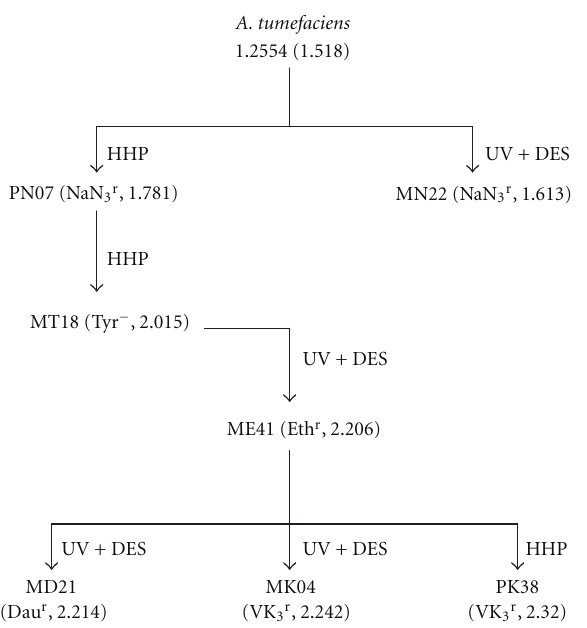
Figure 2: Genealogy of mutant strains derived from AT 1.2554. Mutation markers: NaN 3r , sodium azide (NaN 3 ) resistance; Tyr − , tyrosine auxotroph; Eth r , ethionine resistance; Dau r daunomycin resistance; VK 3r , vitamin K 3 resistance. All the mutants were induced by HHP or UV + DES treatment. The specific CoQ10 content (mg/g dry cell weight) was obtained in flask tests.